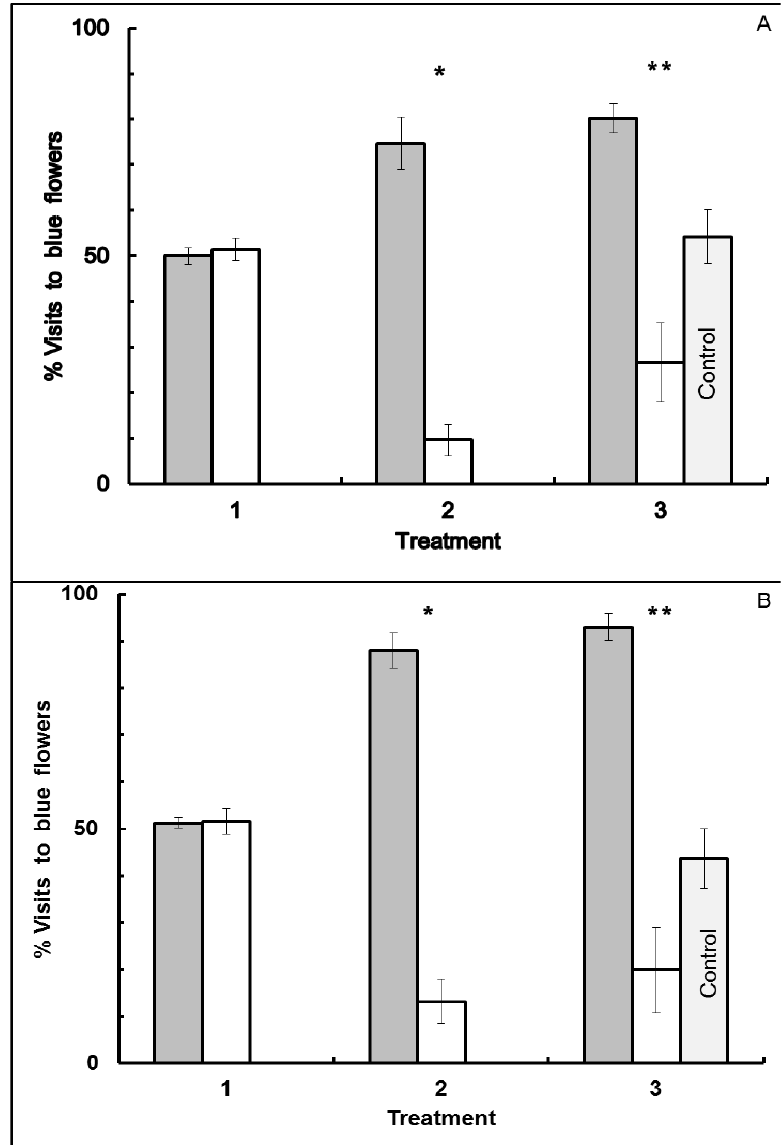
Figure 6. Visitation by bees to blue-white dimorphic flower patches in Experiment IV. Flower shape as well as reward odor, site location and time differed between morning and afternoon flower patches. Percentage of blue flowers visited is presented for blue forager-type bees in Panel ( A ) (N = 12 bees), and for white forager-type bees in Panel ( B ) (N = 13 bees). Error bars indicate ±1 SE. Bar color is by flower color offering the higher molar sucrose reward in Treatment 2: gray bars = bees given the higher molar reward in blue flowers, and white bars = bees given the higher molar reward in white flowers. Treatment 1: morning patch, flat flowers with clove scent, with both blue and white flowers offering the same reward. Treatment 2: morning patch, flat flowers with clove scent, with reward difference between blue and white flowers. Treatment 3: afternoon patch, tube flowers with peppermint scent, with both blue and white flowers offering the same reward. Control represents bees that had never visited the morning patch, and thus never experienced Treatments 1 and 2 (N = 20 bees). * significant difference ( p <